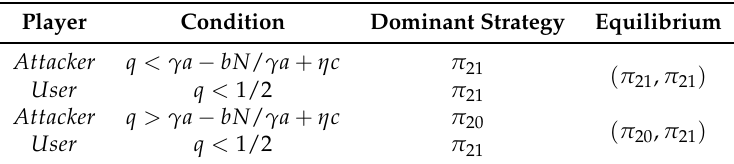
Table 9. List of equilibriums for visitors.